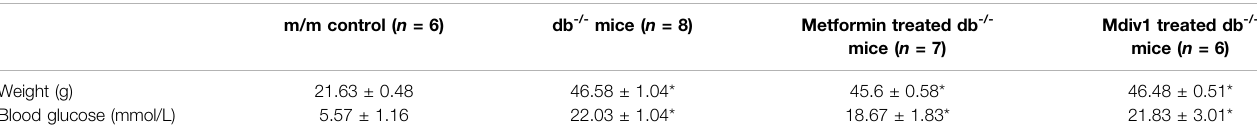
TABLE 1 | General conditions in diabetic mice.